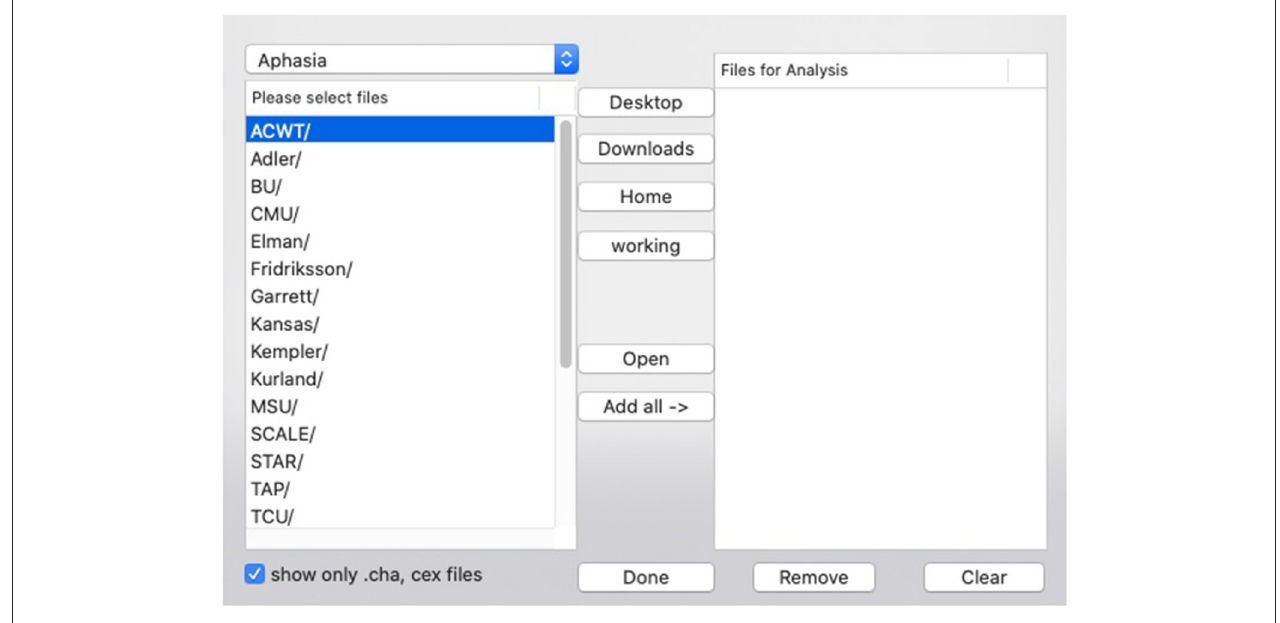
FIGURE 2 | Dialog for file